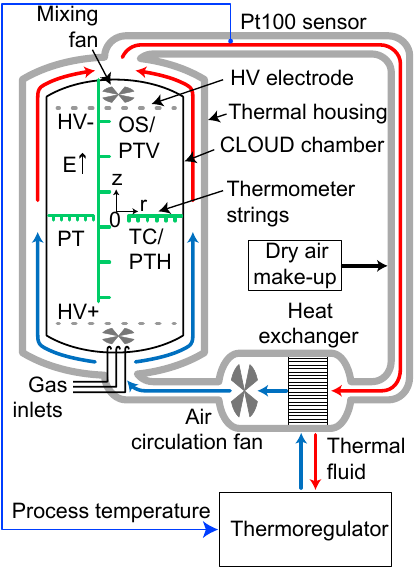
Figure 1. Schematic of the CLOUD thermal system. Thermally controlled air is circulated by a fan at a rate of around 7200m 3 h − 1 within a thermally insulated housing surrounding the stainless steel CLOUD chamber (3m diameter, 26.1m 3 volume). The air is re- turned to the bottom of the chamber along an insulated duct, where it passes through a heat exchanger. A small flow of desiccated air is added to compensate for leaks and ensure that the dew point of the recirculated air remains well below − 80 ◦ C. The air is pre- cisely maintained at a selectable “process temperature” in the range between − 70 and + 100 ◦ C by a 36kW thermoregulator (Unistat 950W; Huber Kältemaschinenbau AG, 2017) which controls the temperature of thermal fluid circulating through the heat exchanger. Fresh make-up air and trace gases continuously enter the chamber to compensate for sampling losses and maintain 5mbar overpres- sure inside the chamber. The chamber air is injected underneath the lower mixing fan ( z = 0m) at rates between 20Lmin − 1 (during sensor calibration) and 210Lmin − 1 (during CLOUD campaigns). During data campaigns, vertical electrical fields of up 20kVm − 1 are generated inside the CLOUD chamber by a pair of HV elec- trodes whose mid-plane (at 0V potential) coincides with the mid- plane of the chamber. The temperature of the air inside the CLOUD chamber is measured by several precision thermometer strings, in- dicated by green lines. The rz cylindrical coordinate axes are indi- cated in the figure, with the origin in the centre of the chamber, as a guide for the sensor positions indicated in Table